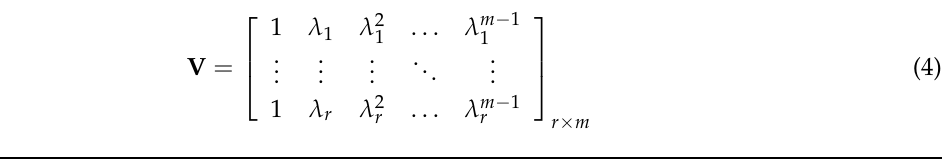
Algorithm 1. The overall procedure of Exact DMD